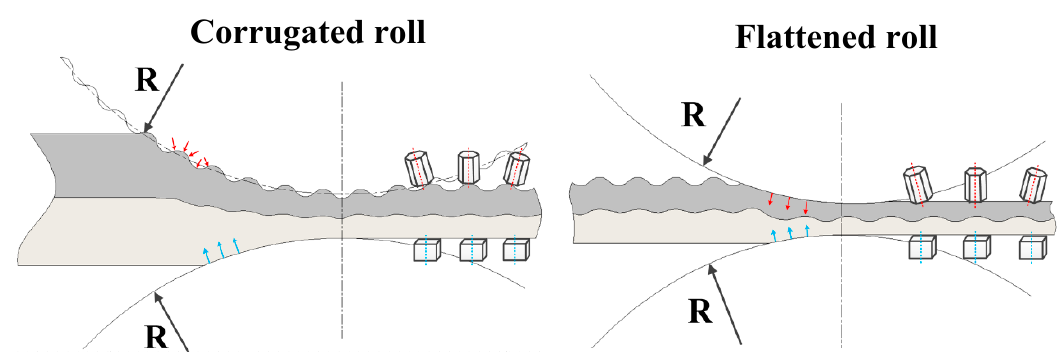
Figure 12. Schematic illustration showing the shear stress during the CFR process.